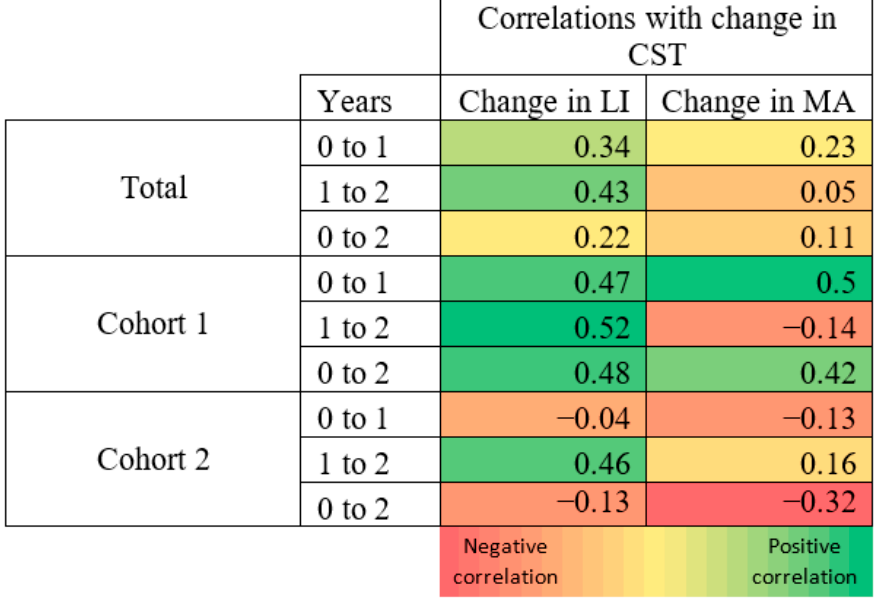
Figure 7. Correlation heat map (red = negative correlation; green = positive correlation). Change in CST correlated to change in leakage index and MA count in the respective time period. Numbers correspond to the Pearson correlation coefficient (r).